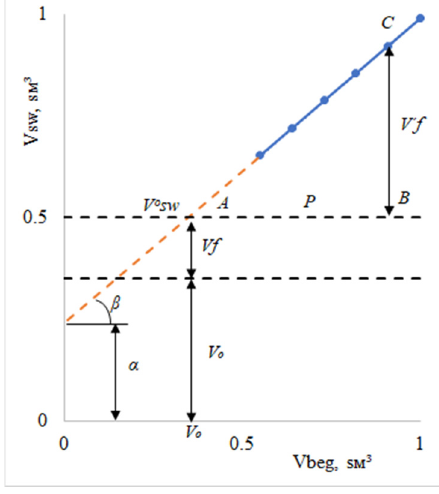
Figure 2. Dependence of V sw on V beg .